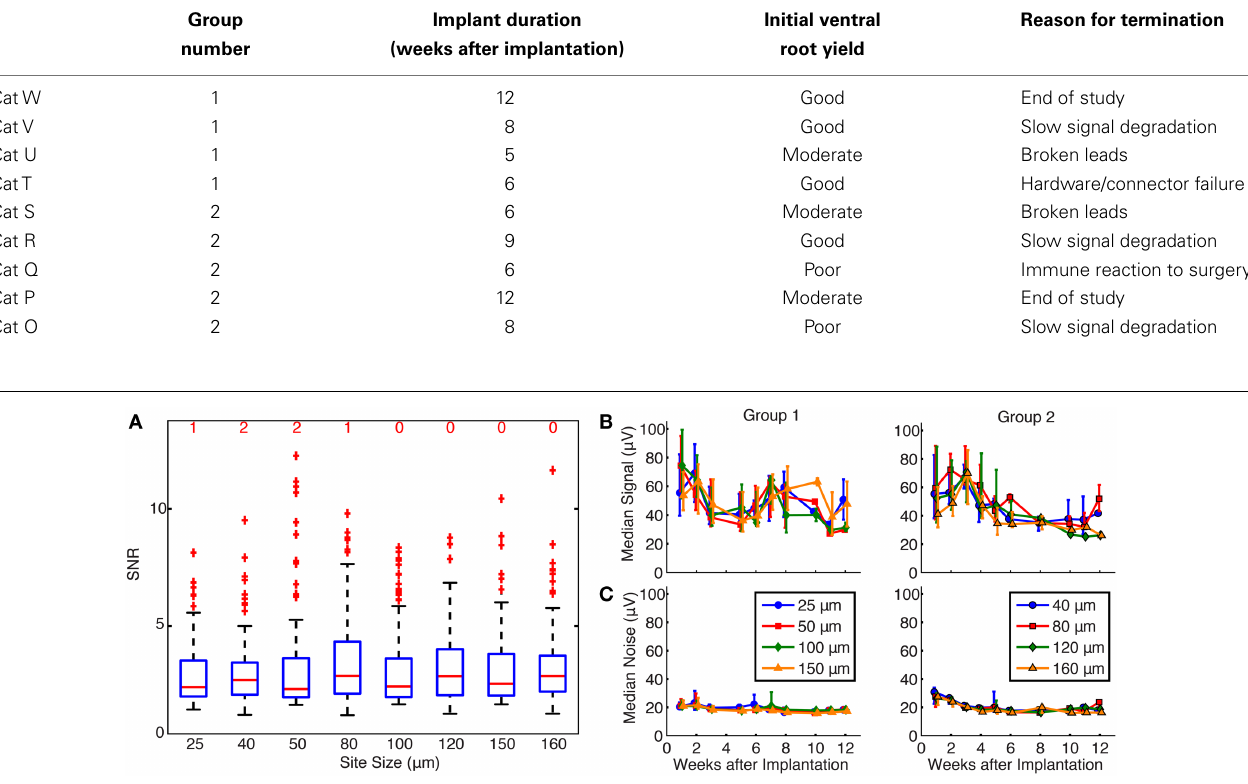
Table 1 | Summary of data collection intervals, initial yield description, and reasons for terminating experiments .